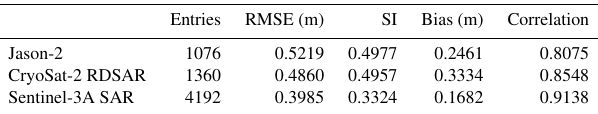
Table 3. Comparison of the data quality within the first 10km off the coast for all three